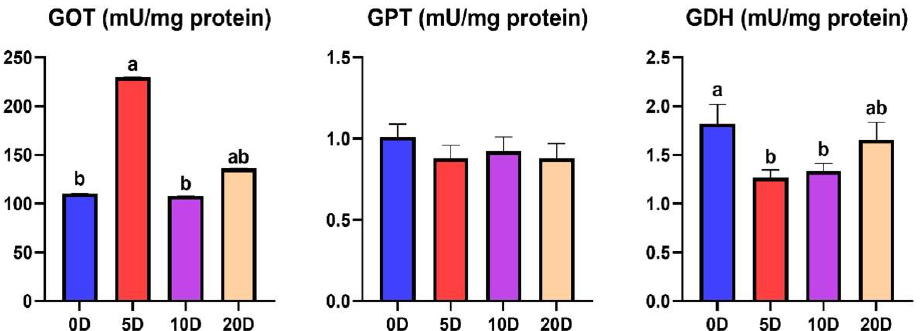
Figure 4. Means ± SEM of the enzyme activities ( n = 18 per treatment) related to protein metabolism in muscle. a, b Different letters indicate significant differences between pre-slaughter times ( p < 0.05). GOT: aspartate aminotransferase; GPT: alanine aminotransferase; GDH: glutamate dehydrogenase. Transformation data for parameters when performing analysis of variance: GOT (log10); GDH (log10). In the transformed variables, the SEM are presented for the transformed data and the means are presented as back-transformed for better interpretation.